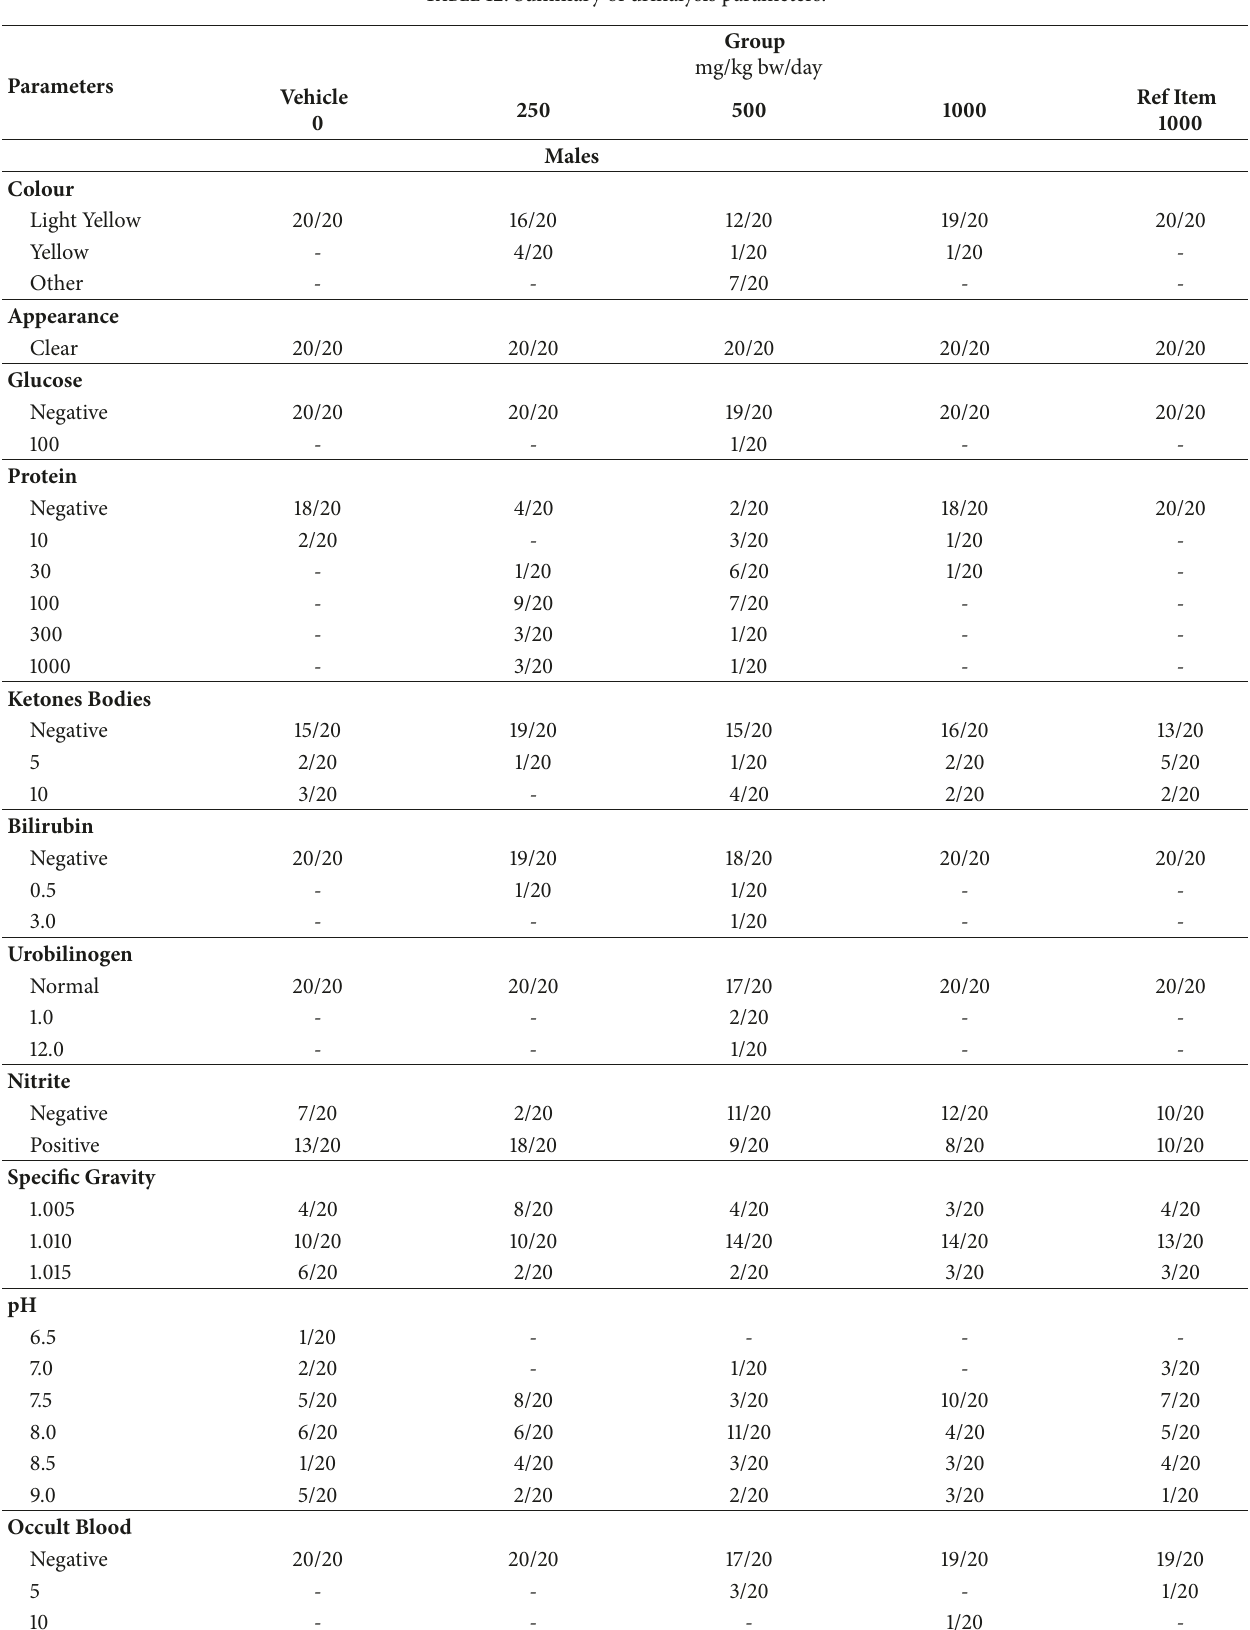
Table 12: Summary of urinalysis